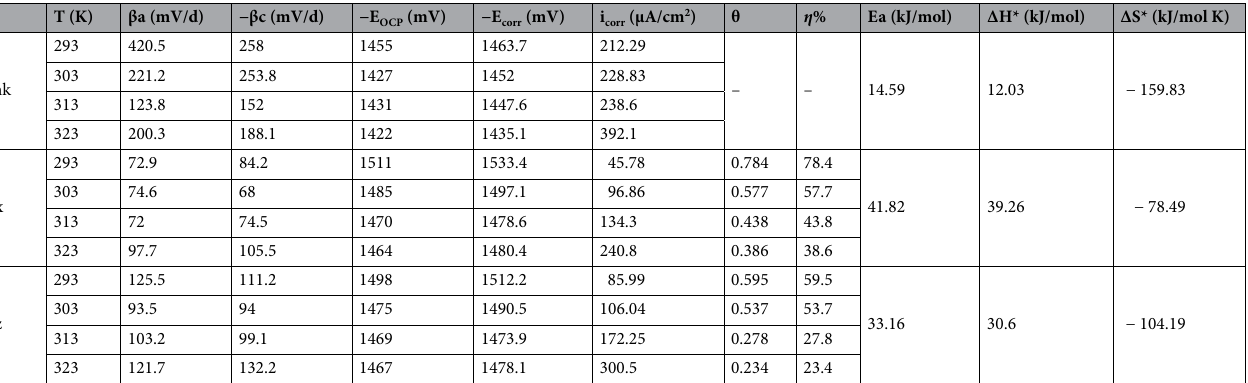
Table 2. Electrochemical and thermodynamic kinetic parameters and inhibition efficiencies of Al in 0.1 M NaOH solution based on PDP in the absence and presence of 300 ppm Cefx and Cefz drugs at different temperatures.